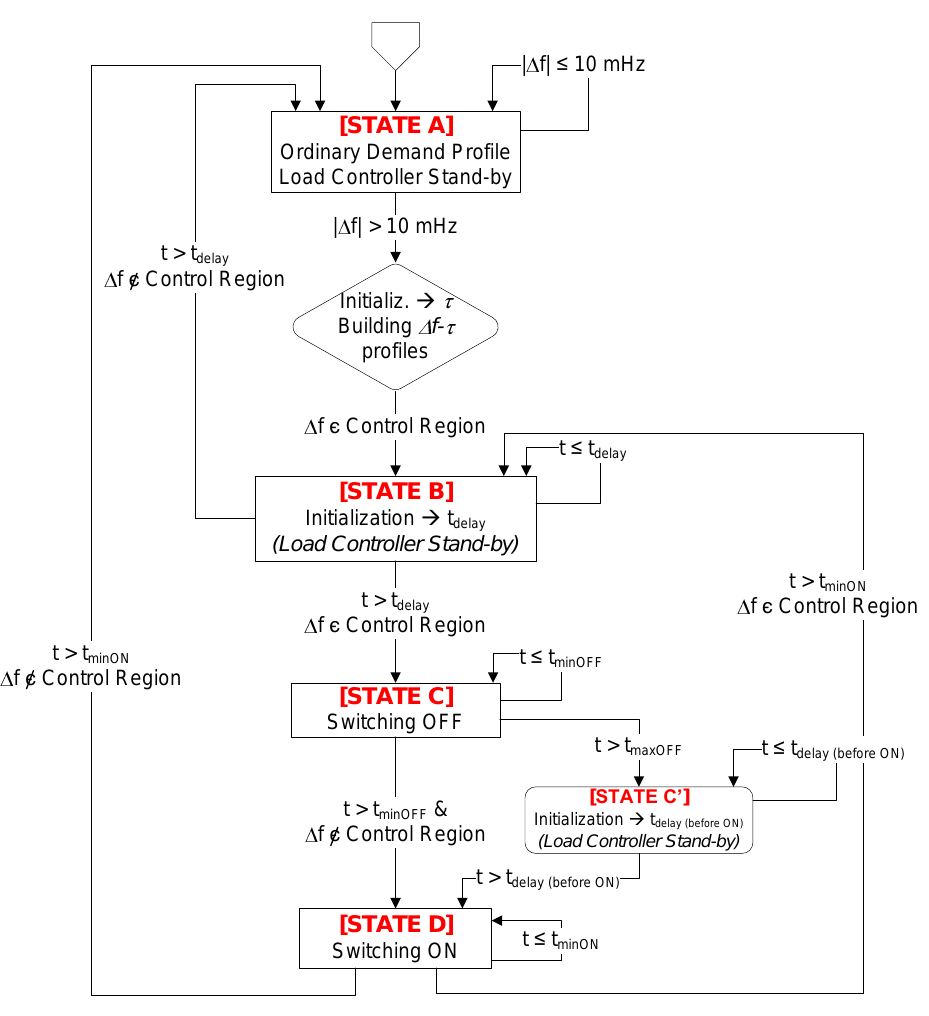
Figure 6. Overview of the load control scheme for under-frequency events.